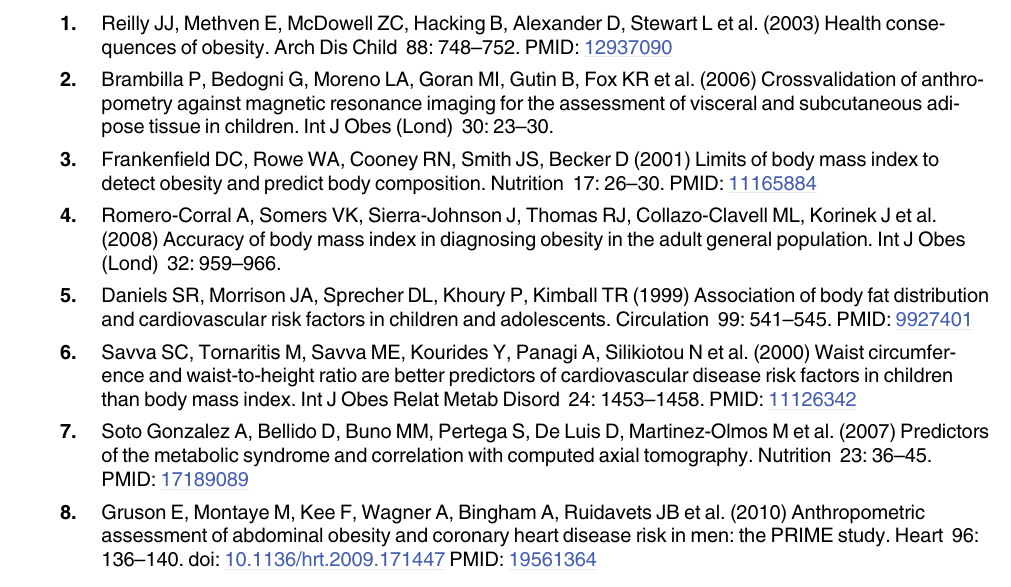
S1 Table. Characteristics of 4115 Canadian children and youth aged 6 to 19 years in the Canadian Health Measures Survey Cycles 1 and 2. S2 Table. Percentiles of body mass index, waist circumference, and waist-to-height ratio that intersect adult cutpoints at age 18